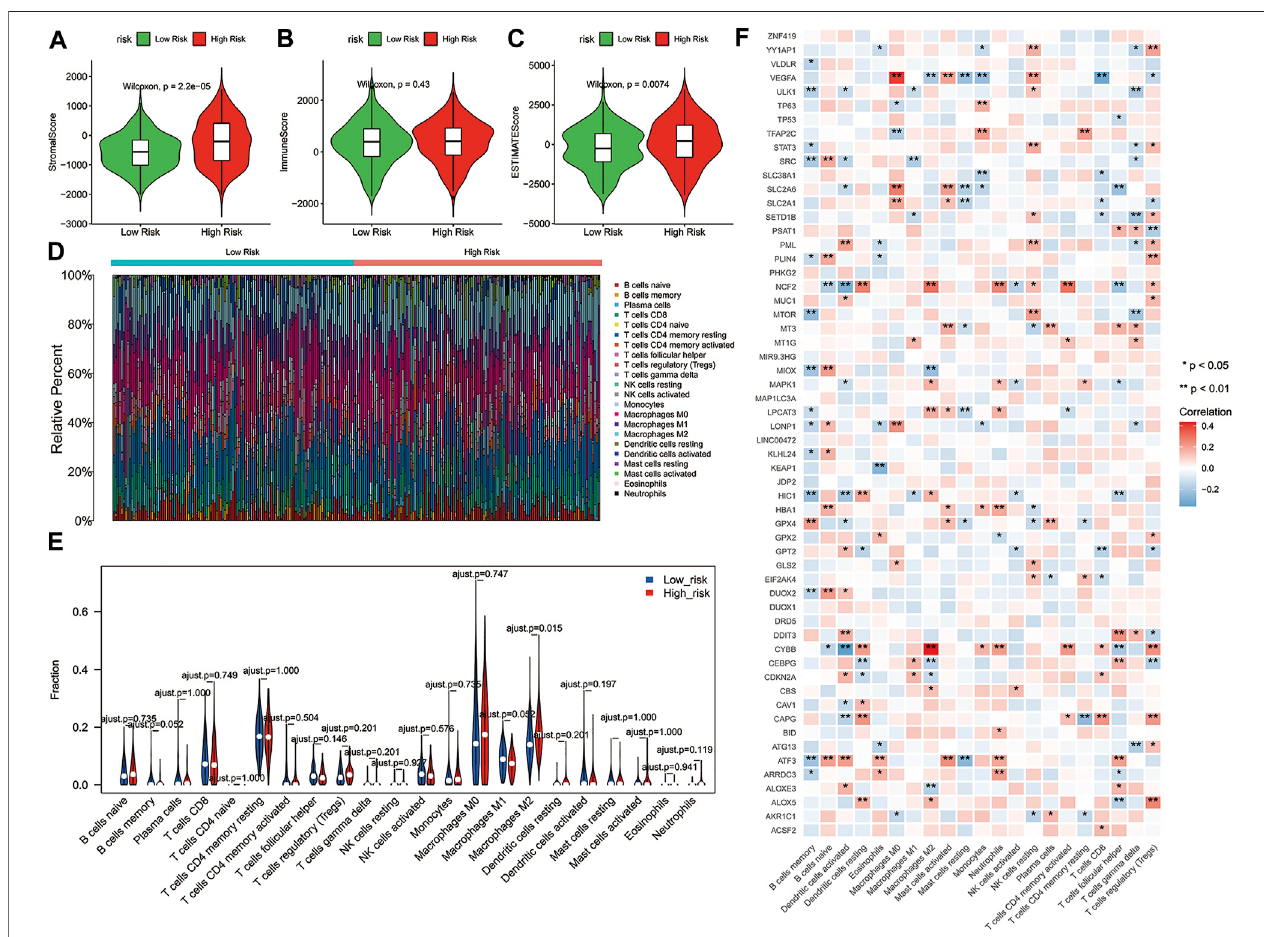
FIGURE 5 | Correlation between the 3-gene signature risk score and immune status. (A – C) The differences of Stromal scores, Immune scores and ESTIMATE scores in two risk groups. (D) Barplot showed the composition of 22 immune cells in each patient from the high-risk and low-risk groups analyzed by CIBERSORT. (E) TheViolinplotshowedtheratiodifferentiationof22immunecellsbetweenOCsampleswithhighorlowriskscores,andWilcoxonranksumwasusedforthesigni fi cance test. (F) Heatmap showing the correlation between 22 kinds of immune cells and the DE-FRGs, the asterisk in each tiny box indicating the p value of correlation between two kinds of parameters. The shade of each tiny color box represented corresponding correlation value between two parameters, and Spearman coef fi cient was used for signi fi cance test. ESTIMATE, Estimation of STromal and Immune cells in MAlignant Tumor tissues using Expression data; DE-FRGs, Differentially Expressed-ferroptosis-related